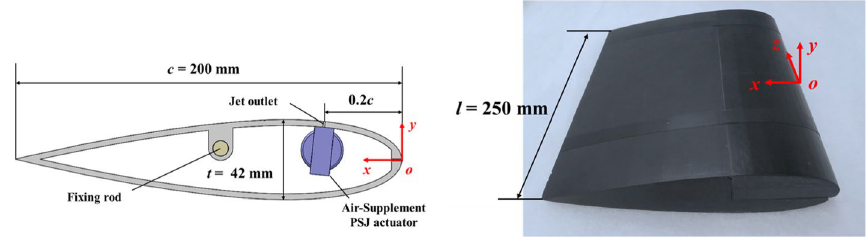
Fig. 6 Schematic of the 2D airfoil